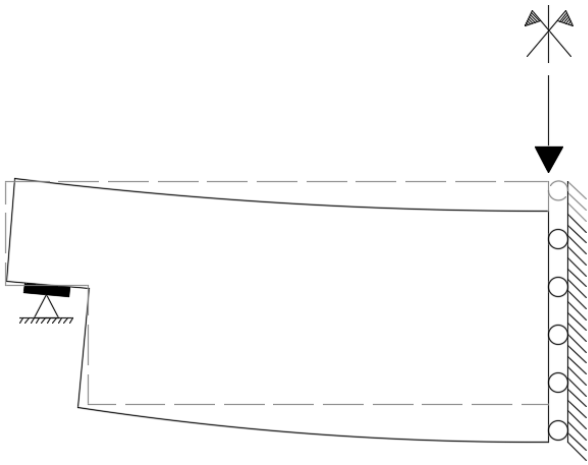
Figure 14. Boundary condition of the FE model.